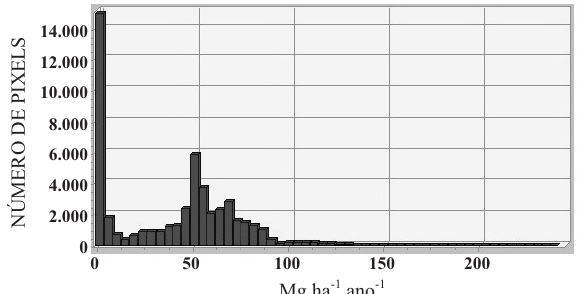
Figura 8. Histograma de freqüência das taxas médias de perda de solo estimadas pela EUPS (A, Mg ha -1 ano -1 ) na área de